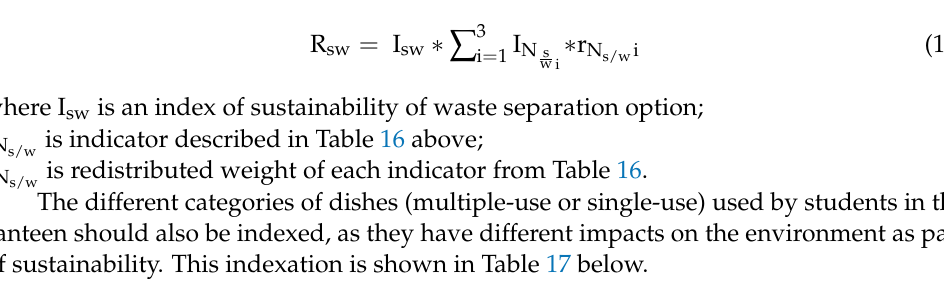
Table 17. Index system for dishes category.